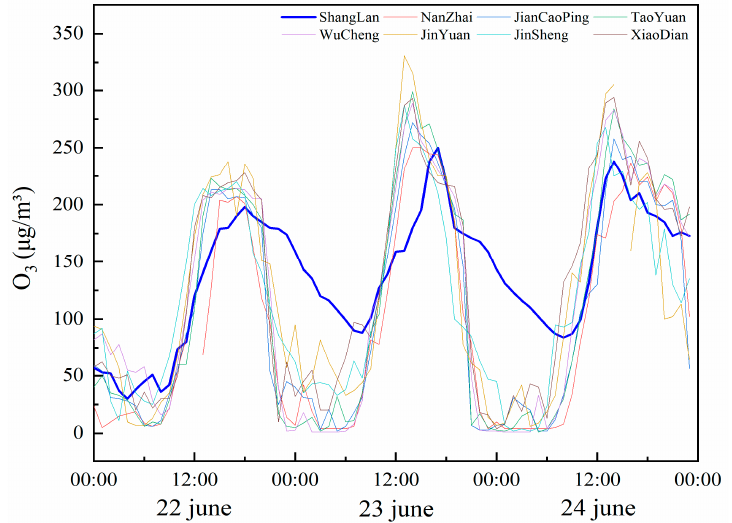
Figure 10. Variation of O3 concentration at the national monitoring sites in Taiyuan during 22–24 June.